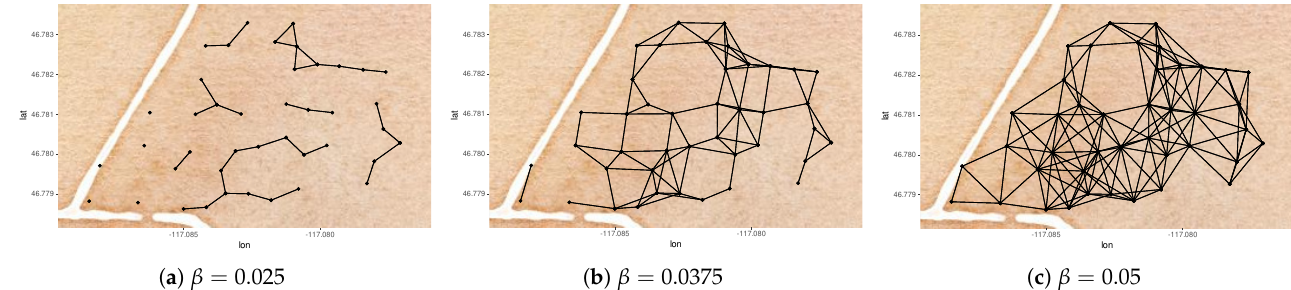
Figure 8. Spatial neighbours at maximum spatial radius within each spatiotemporal neighbourhood with α = 0.25 and different values of β for dataset Cook Agronomy Farm.